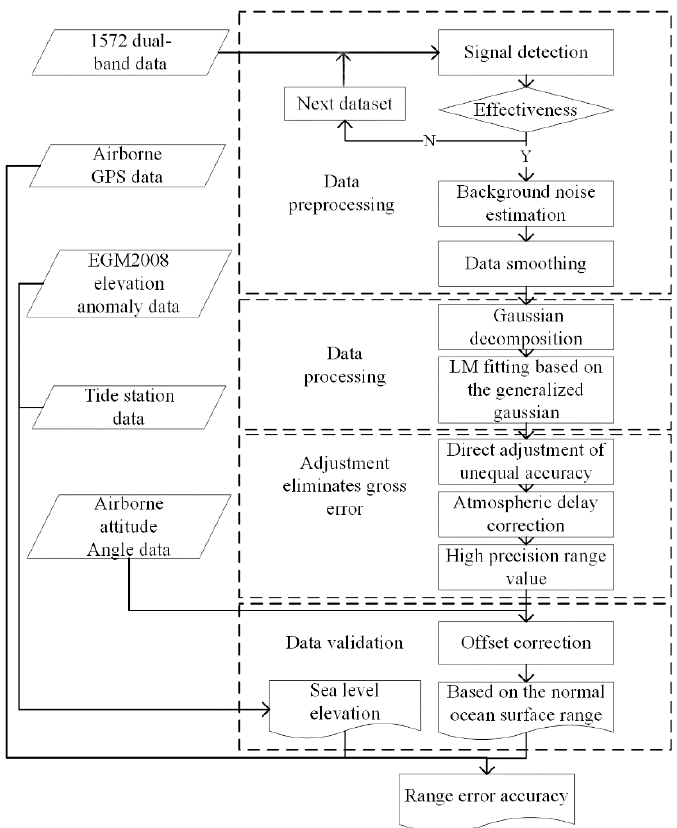
Figure 2. Flowchart of data processing.